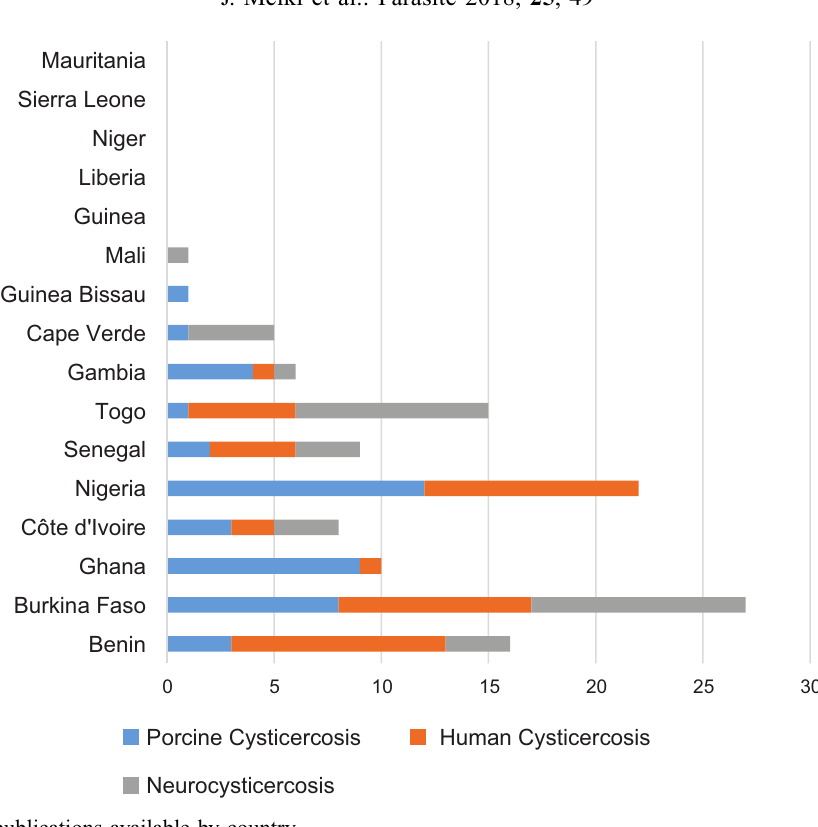
Figure 2. Summary of publications available by